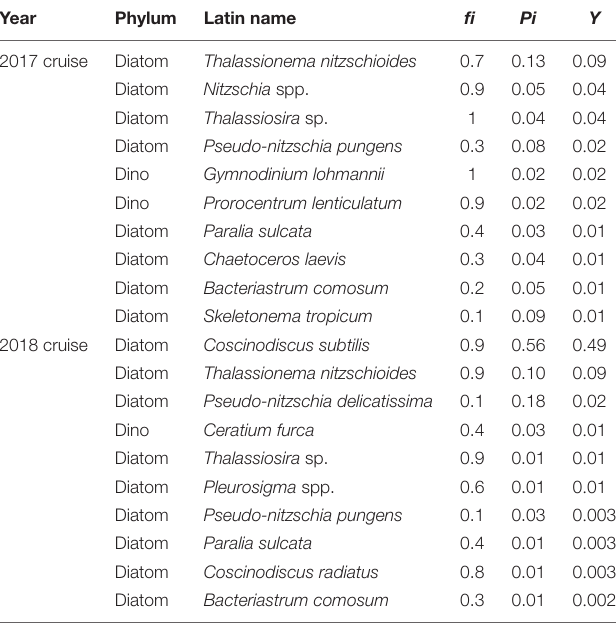
TABLE 2 | List of 20 dominant species in two